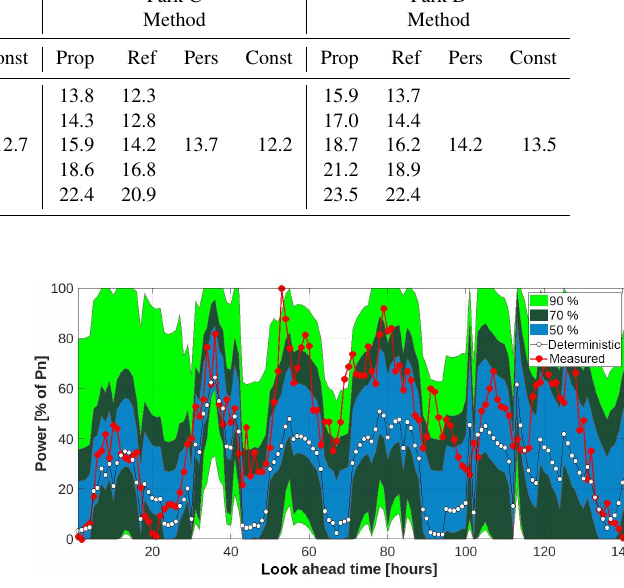
Figure 6. Example of probabilistic forecast for three confidence lev- els 100 · ( 1 − a) % applying the Prop method, deterministic forecast and measured power time-series for park